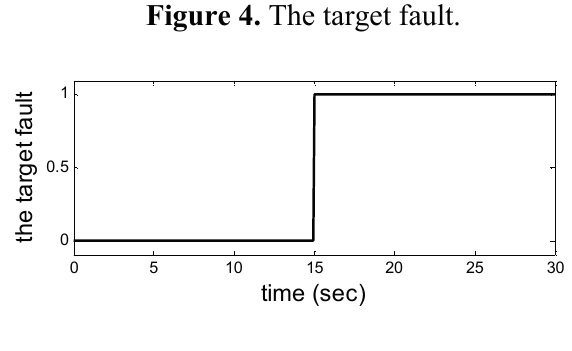
Figure 5. The assistant state bias.